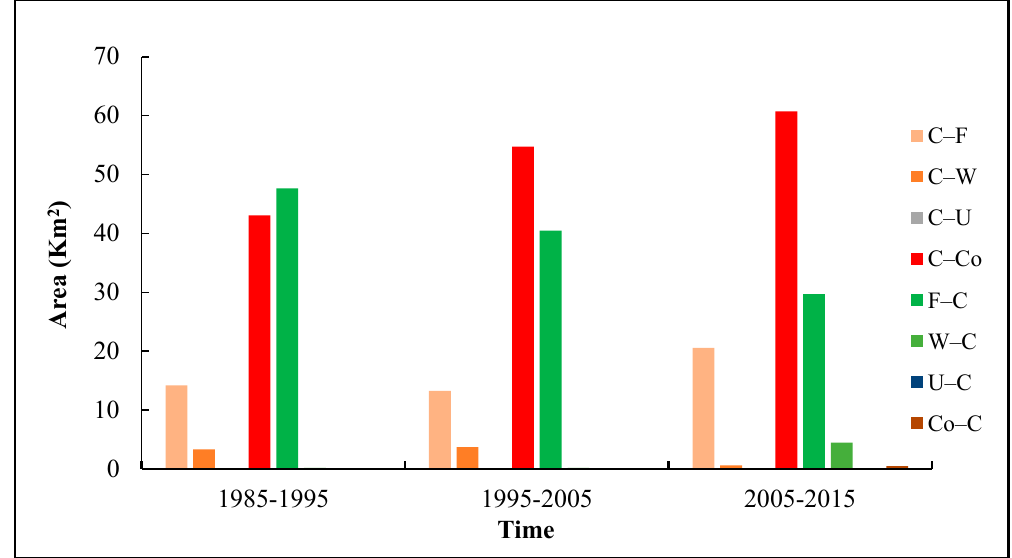
Figure A4. Area of cultivated land conversion statistics.